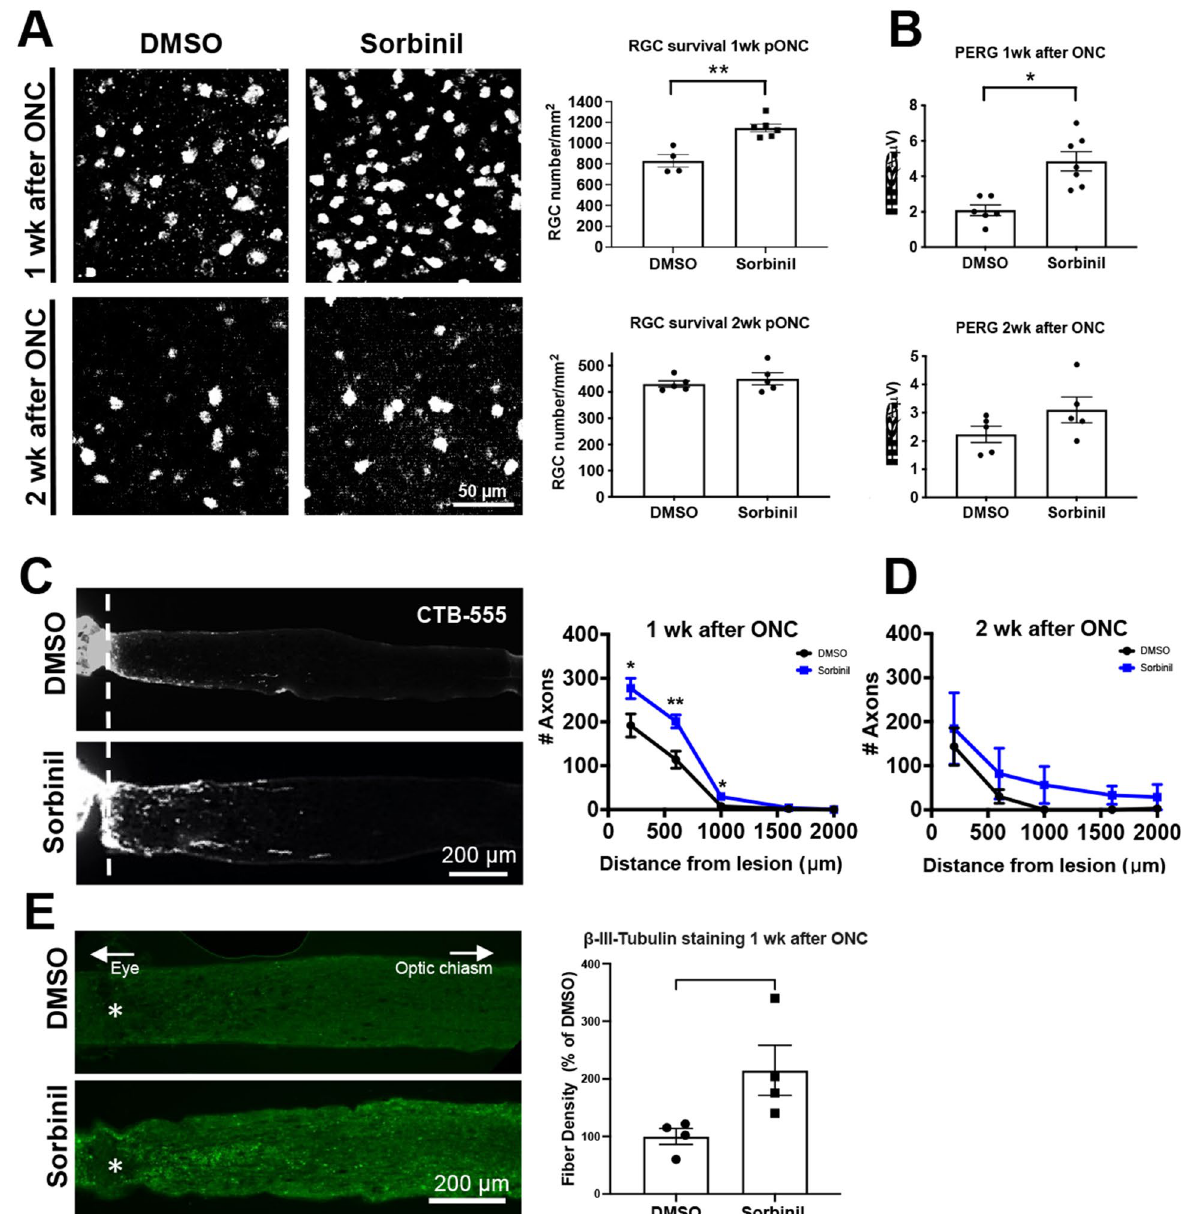
Figure 3. Sorbinil promotes RGC survival, RGC function and delays RGC degeneration one week after ONC. (A) Flat-mount retinas were immunostained against RGC-specific marker RBPMS. Sorbinil treatment significantly improves RGC survival one week after ONC, but not two weeks after ONC. (B) RGC activity was measured by pattern electroretinography (pERG) in adult retinas. Sorbinil treatment significantly improves pERG one week after ONC. Regenerating axons were visualized by CTB-555 injection two days before euthanasia. (C) Sorbinil treatment significantly increases CTB-555 labeled axons one week after ONC. (D) Sorbinil does not promote ON regeneration two weeks after ONC. (E) Sorbinil treatment significantly delays ON degeneration one week after ONC, as measured by the abundance of βIII-Tubulin staining protein expression. The dashed line in (C) and asterisk in (E) mark the site of ONC. ( A , B, C, N > 6 eyes per group; D , N = 5 eyes per group; E, N = 4 eyes per group. Statistical significance was determined using one-way ANOVA and post hoc t-test with Tukey correction (* P < 0.05, ** P < 0.01). Mean ± SEM is